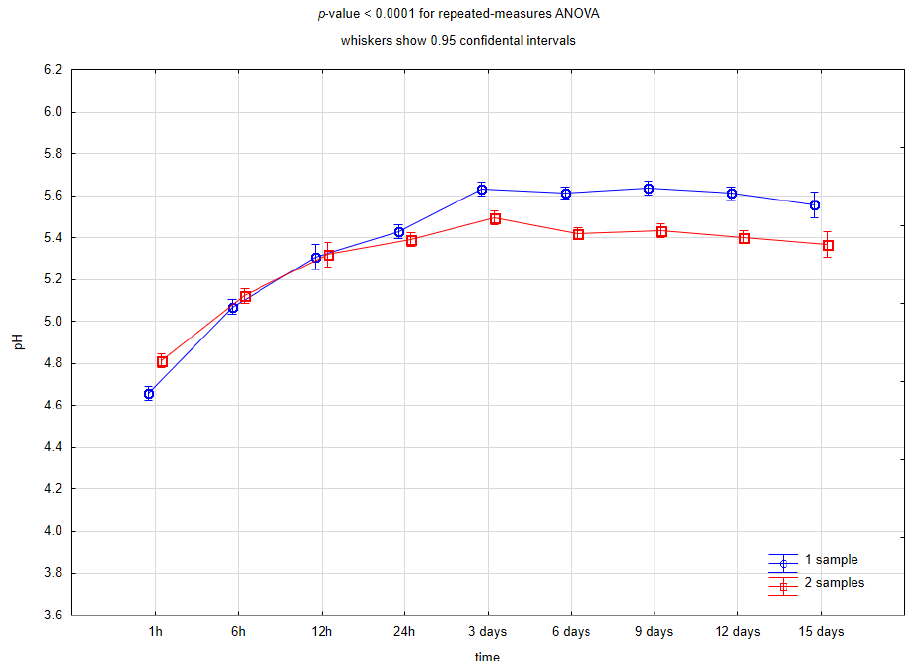
Figure 5. Repeated-measures analysis of variance for pH values in the individual time-points depending on the number of the samples for RIVA SC.